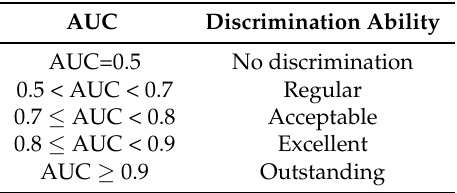
Table 4. Assessment rules of AUC [38].